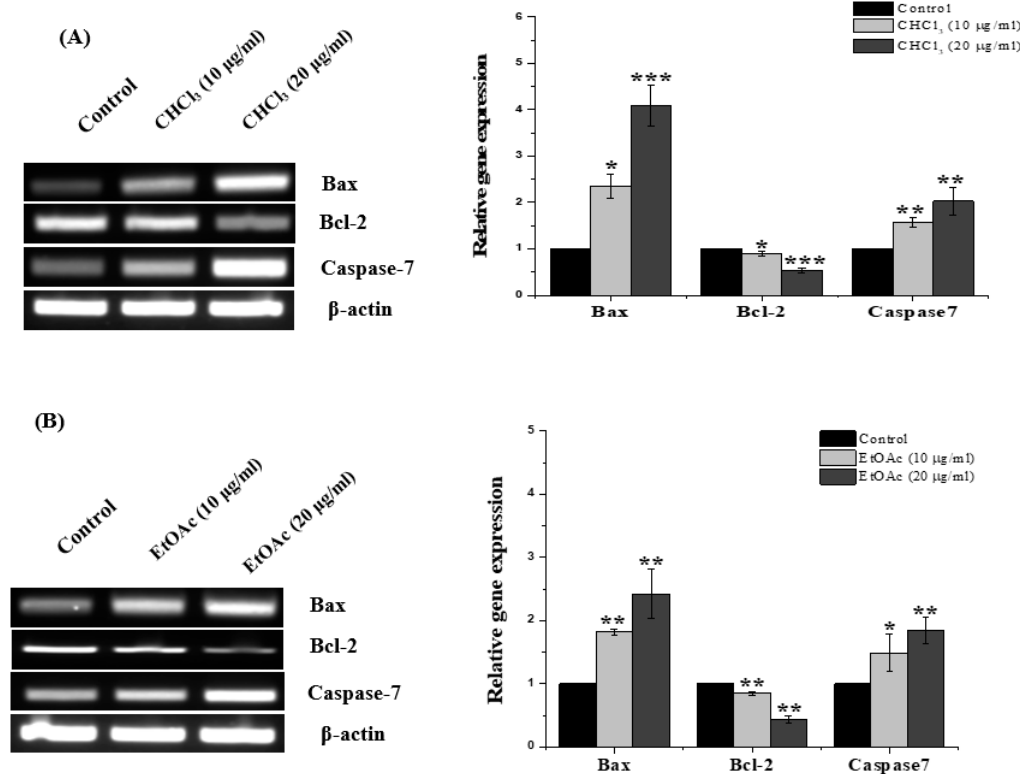
Figure 7. Gene-expression analysis of Bcl-2, Bax and caspase-7 after incubation of MCF-7 cells with 10 and 20 µg/mL of ( A ) E. saudiarabica CHCl 3 fraction and ( B ) E. saudiarabica EtOAc fraction. Histograms showing densitometry analysis, in which band intensity was measured and normalized to that of β -actin. Data shown are means ± SD ( n = 3) (* p < 0.05, ** p < 0.01 and *** p < 0.001 vs. control).